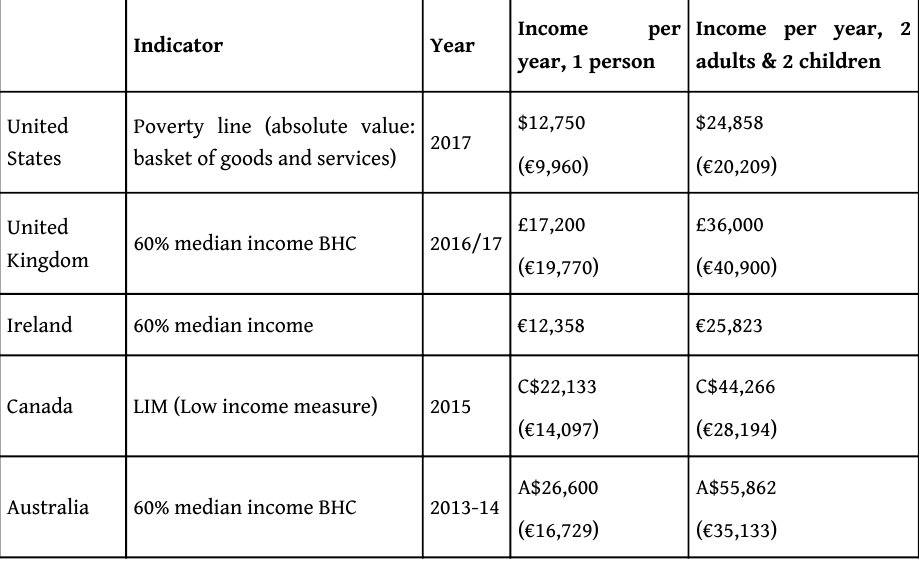
Table 1: Monetary Values of Poverty Thresholds (and equivalent in euros*) 3